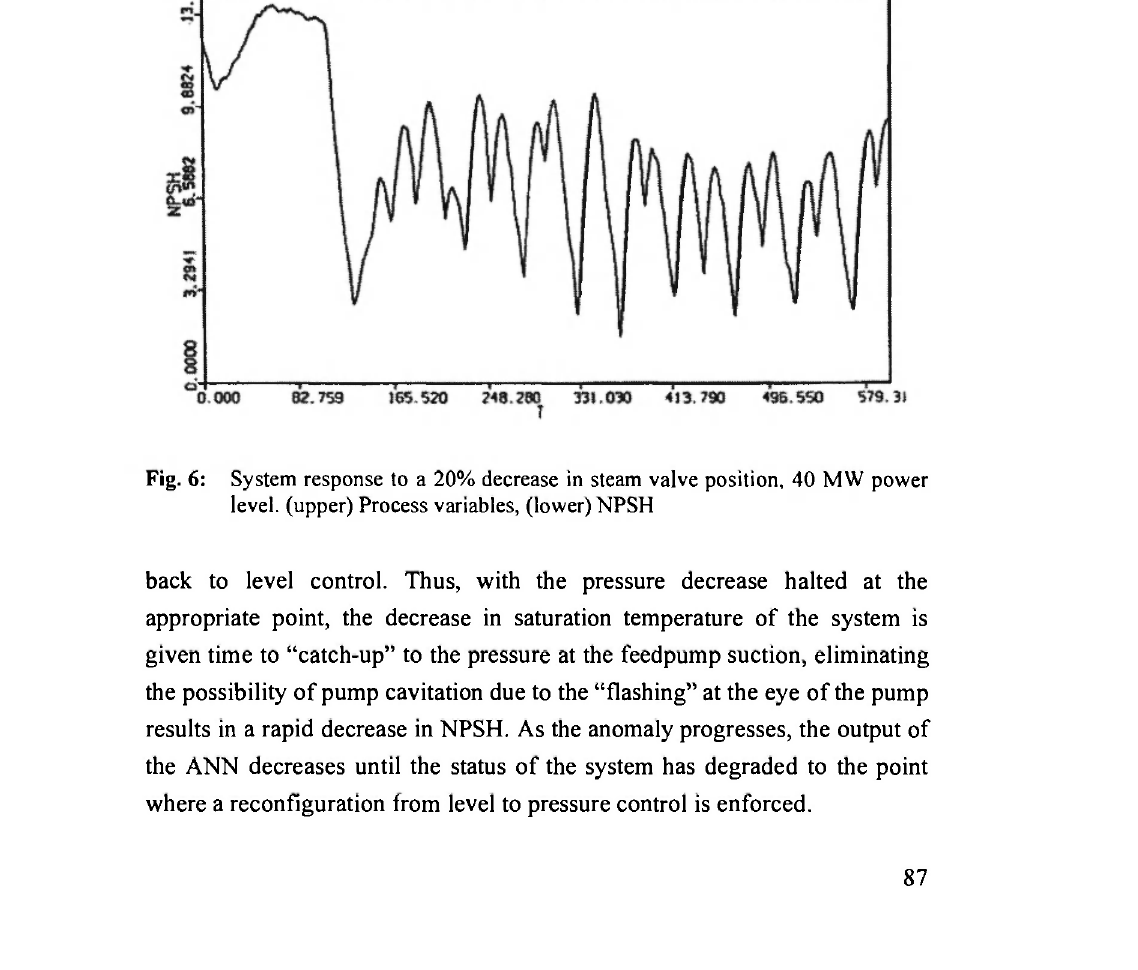
Fig. 6: System response to a 20% decrease in steam valve position, 40 MW power level, (upper) Process variables, (lower) NPSH